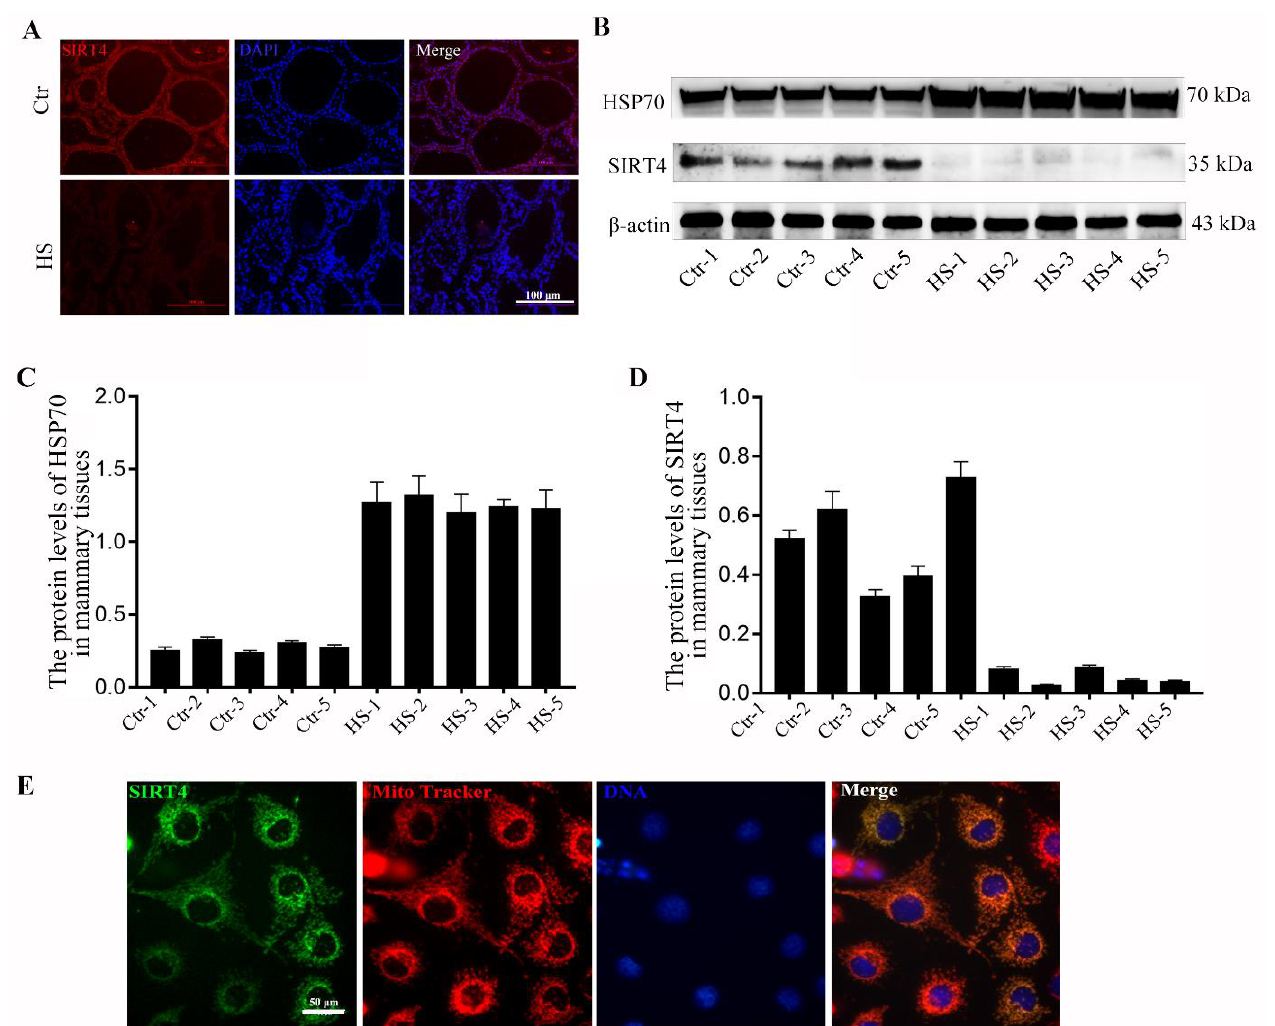
Figure 1. SIRT4 expression and localization in dairy cow mammary tissue. ( A ) The localization of SIRT4 in mammary tissue in control and heat stress-treated group. ( B – D ) The protein and mRNA levels of SIRT4 and HSP70 in mammary tissues were examined by Western blot and qRT-PCR after heat stress treatment. ( E ) SIRT4 was colocalized with mitochondria in BMECs.